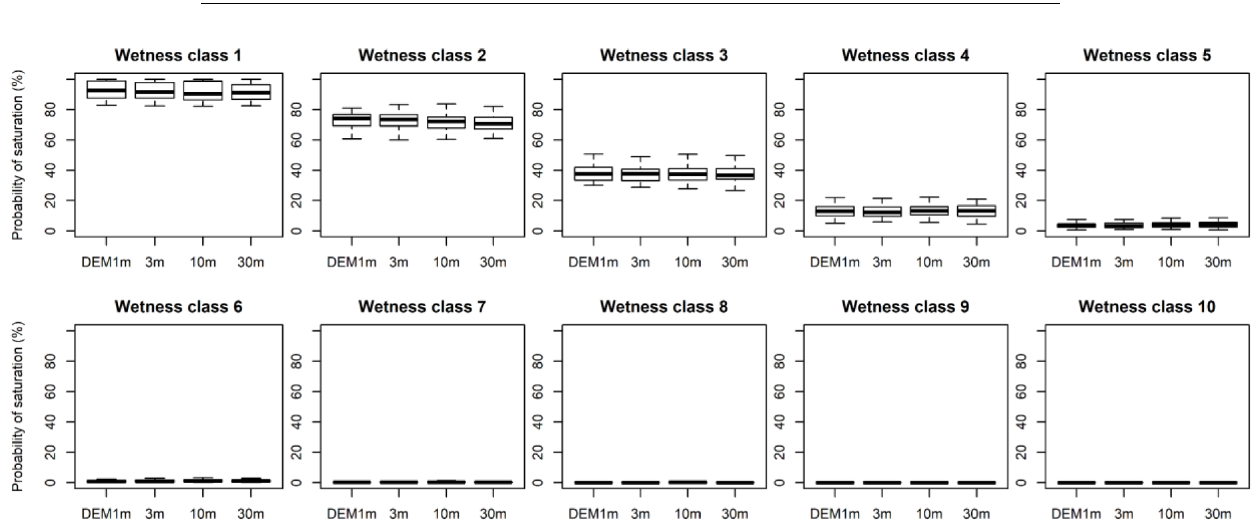
Figure 6. Probability of saturation of wetness classes in SWAT-HS setups with different DEM resolutions using good parameters for both streamflow and saturated